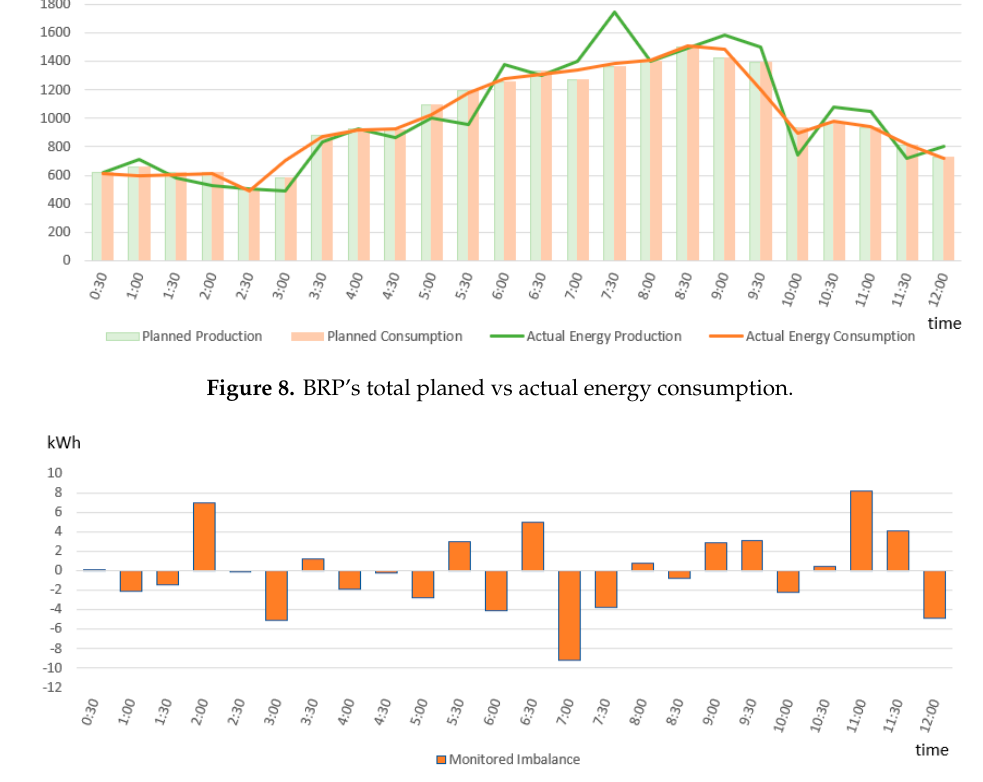
Figure 9. Tracking the deviations of Prosumer1 from energy plan.